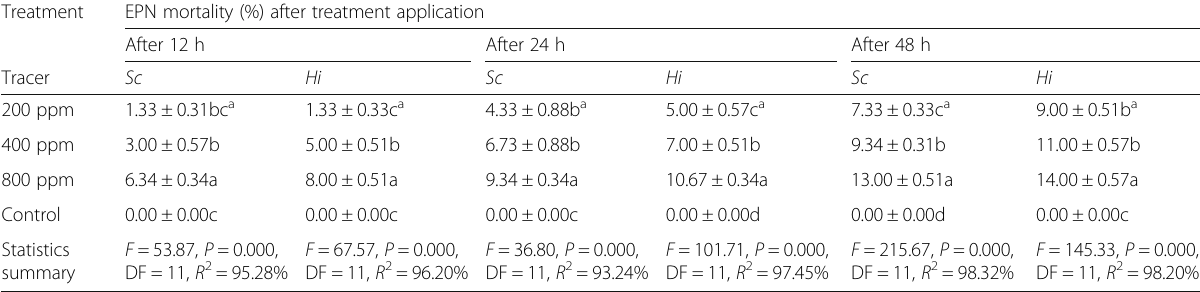
Table 2 Toxicity of Tracer® 240SC against the entomopathogenic nematode species Treatment EPN mortality (%) after treatment application After 12